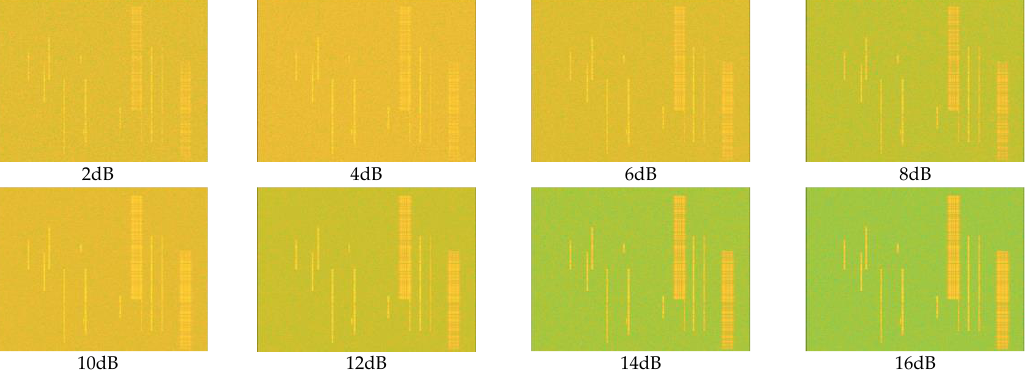
Figure 9. Comparison of the differences in the time-frequency diagrams generated at each SNR.